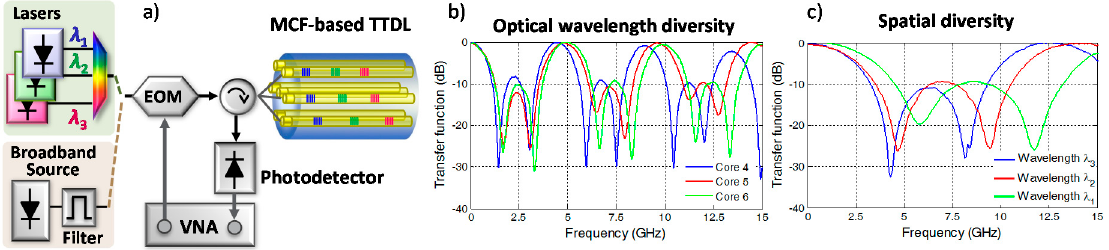
Figure 7. ( a ) Microwave signal fileting experimental setup; and measured radiofrequency responses operating in: ( b ) wavelength diversity (for each one of the radiated cores); and ( c ) spatial diversity (for each one of the optical wavelengths) [51].